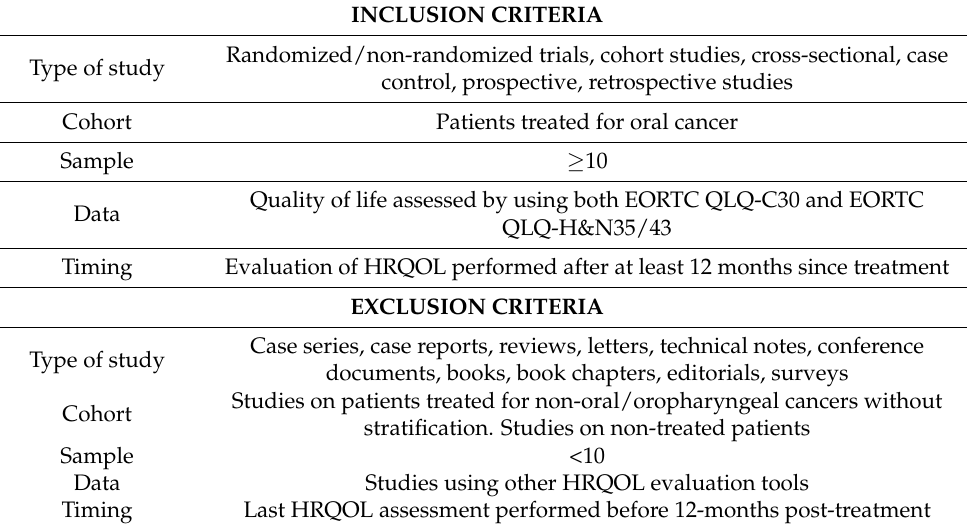
Table 1. Inclusion/exclusion